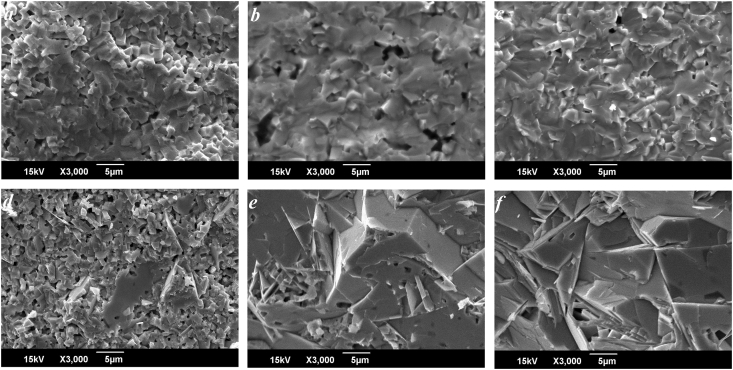
Fragments of the microstructure of the NSN ceramics obtained at various TSin: x = 0.10 (a–c); x = 0.25 (d–f); (a, d) TSin = 1520 K; (b, e) TSin = 1570 K; (c, f) TSin = 1620 K.